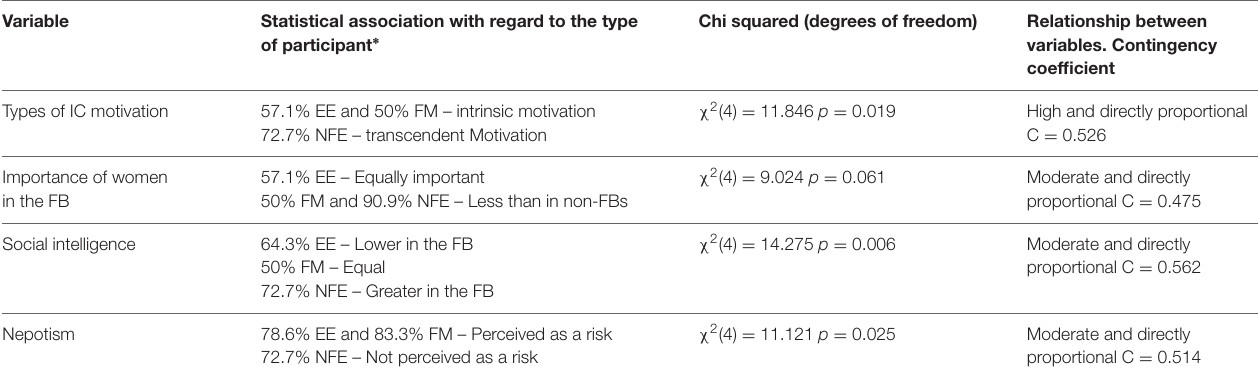
TABLE 1 | Association between variables of the study with regard to the characteristics of the IC. Variable Statistical association with regard to the type of participant ∗